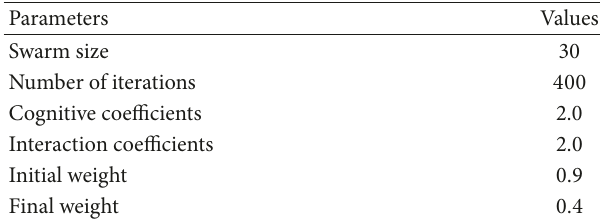
Table 3: Parameter selection of the